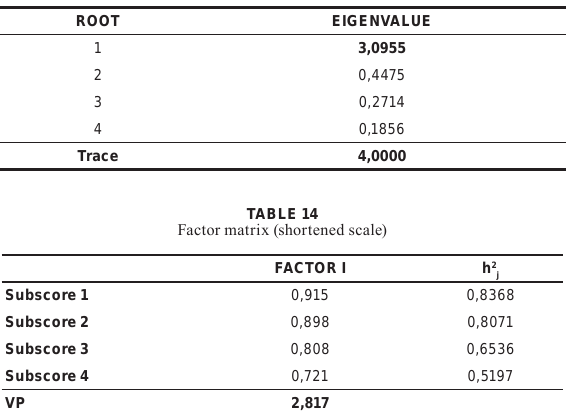
Work performance questionnaire: (shortened scale) rotated factor matrix (varimax